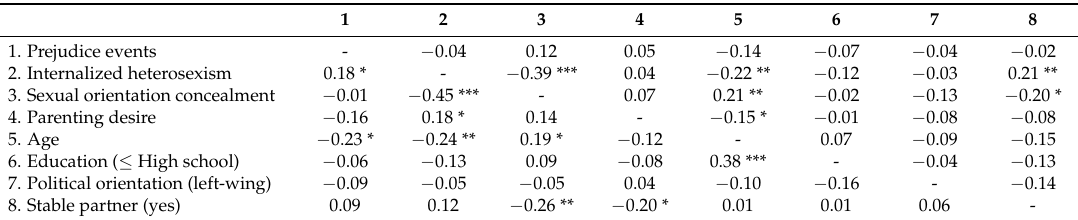
Table 2. Descriptive statistics and bivariate correlations between minority stressors, parenting desire, and sociodemographic characteristics. 1 2 3 1. Prejudice events